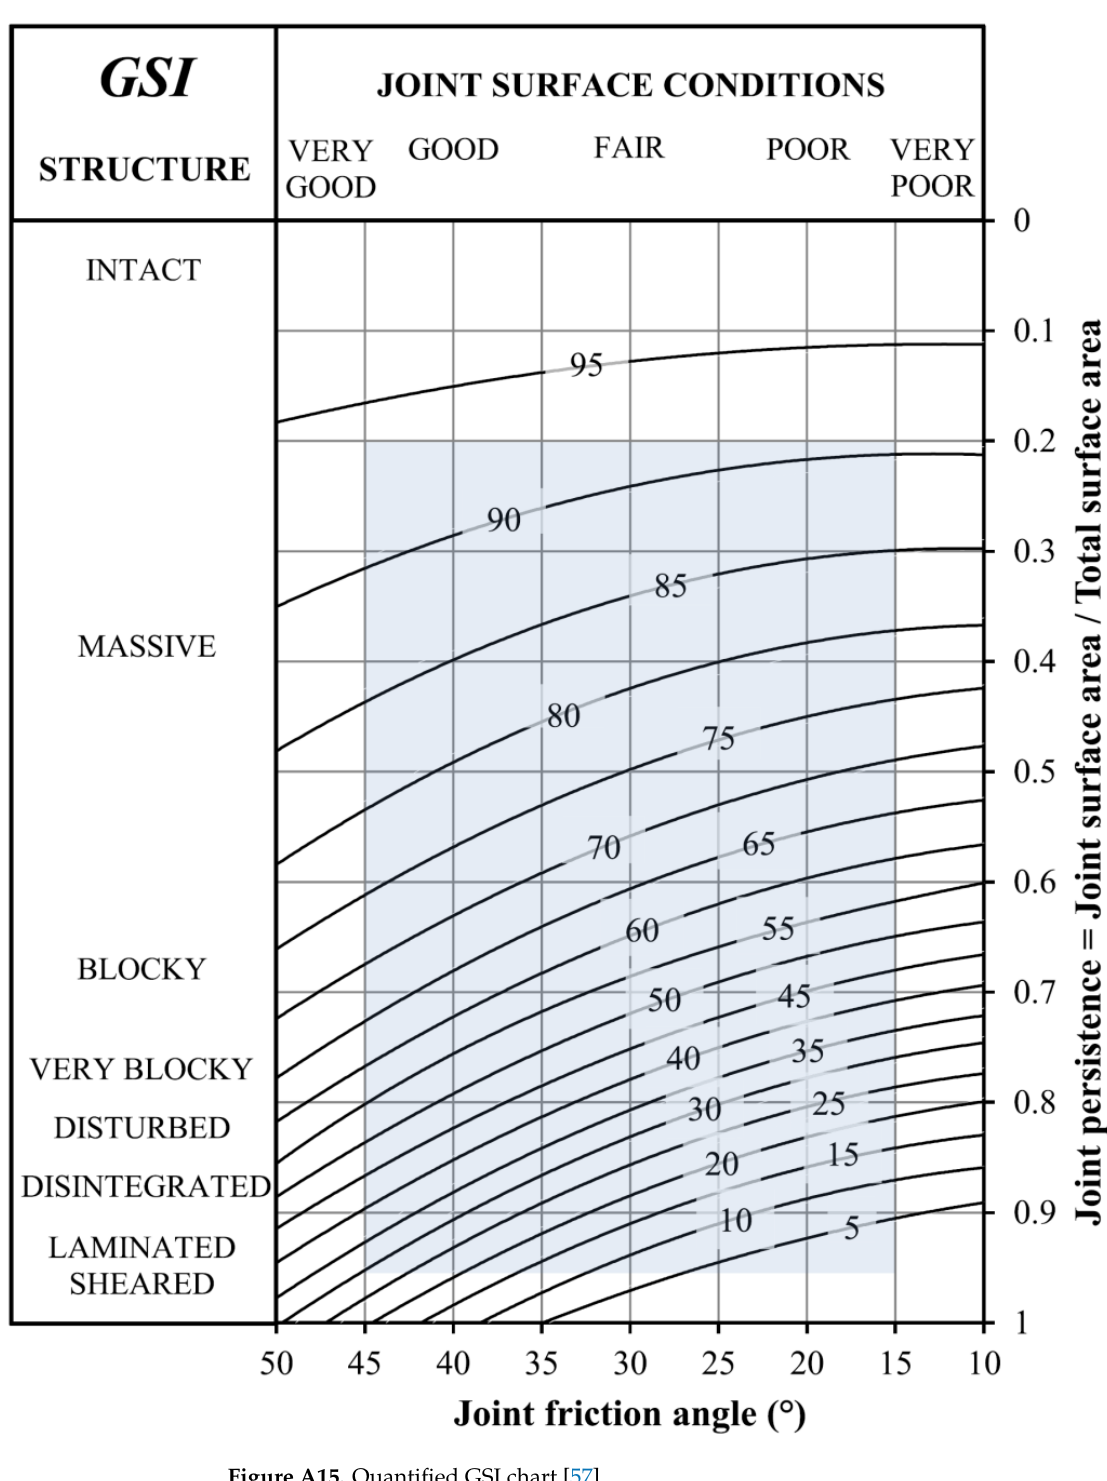
Figure A15. Quantified GSI chart [57].